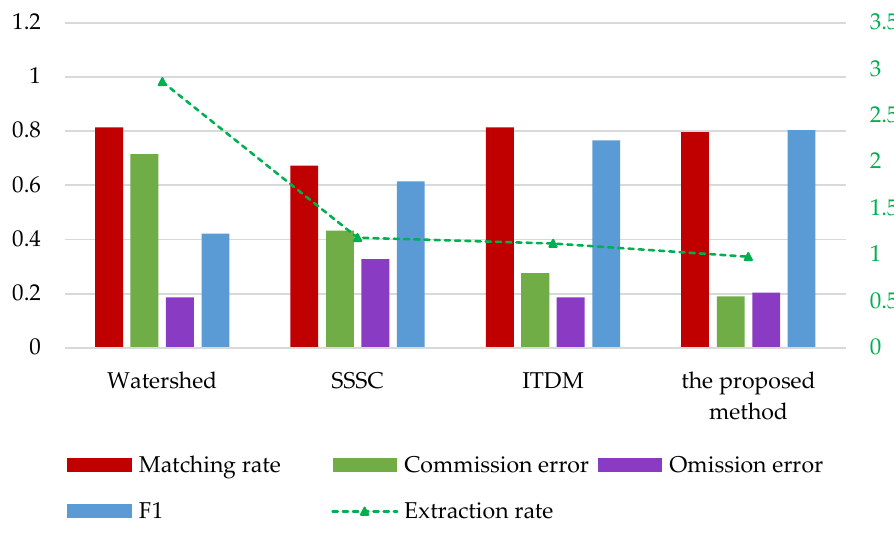
Figure 12. Accuracy comparison among four different methods in Sample 1.